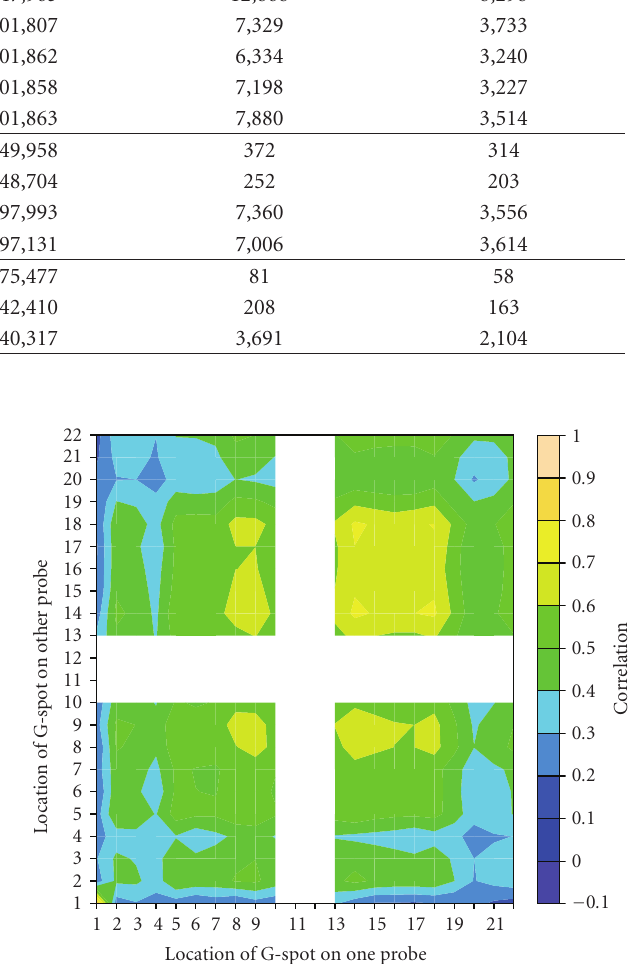
Figure 1: Contour plot illustrating that in human chip HG U133A, the average correlation coe ffi cient values changes according to the position of G-stack (with four Gs only) for a group of probes.